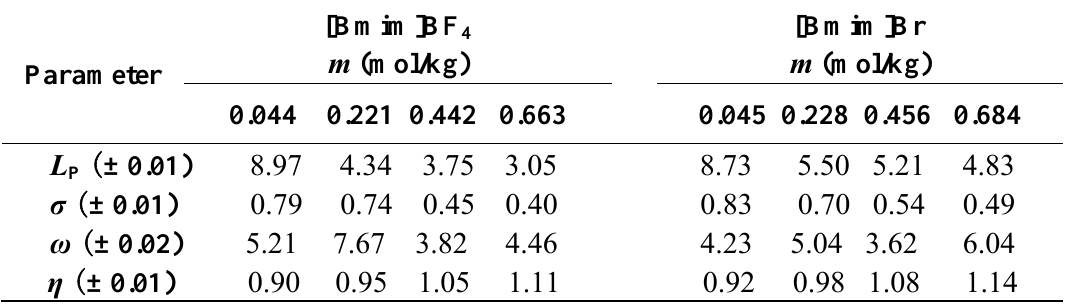
Table 1. Viscosities and Practical transport coefficients ( L mol/m 2 s MPa) for nanofiltration of aqueous solutions of Ils.